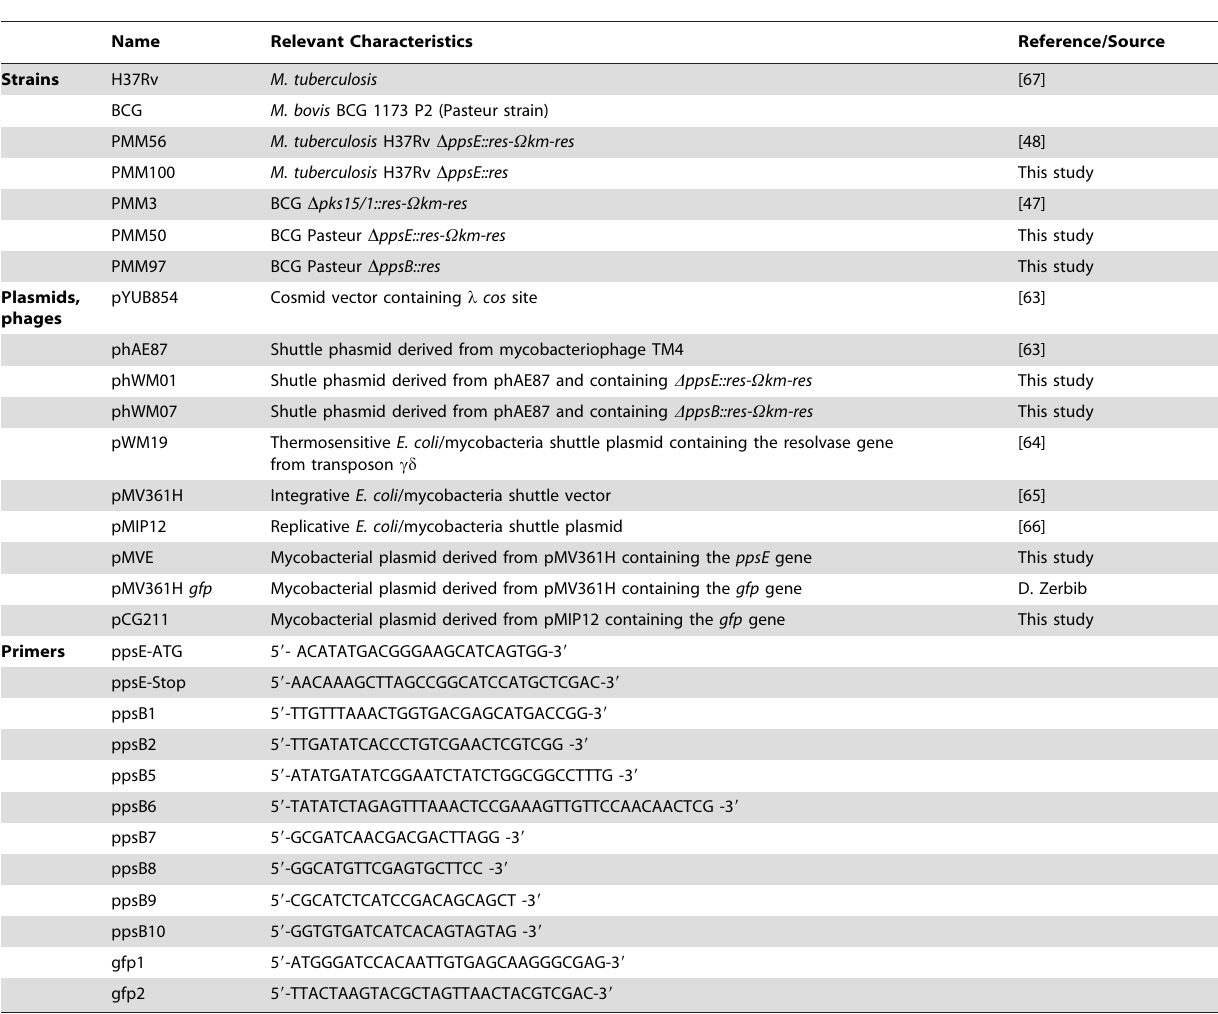
Table 1. Name and main features of strains, plasmids, and primers used in this study.